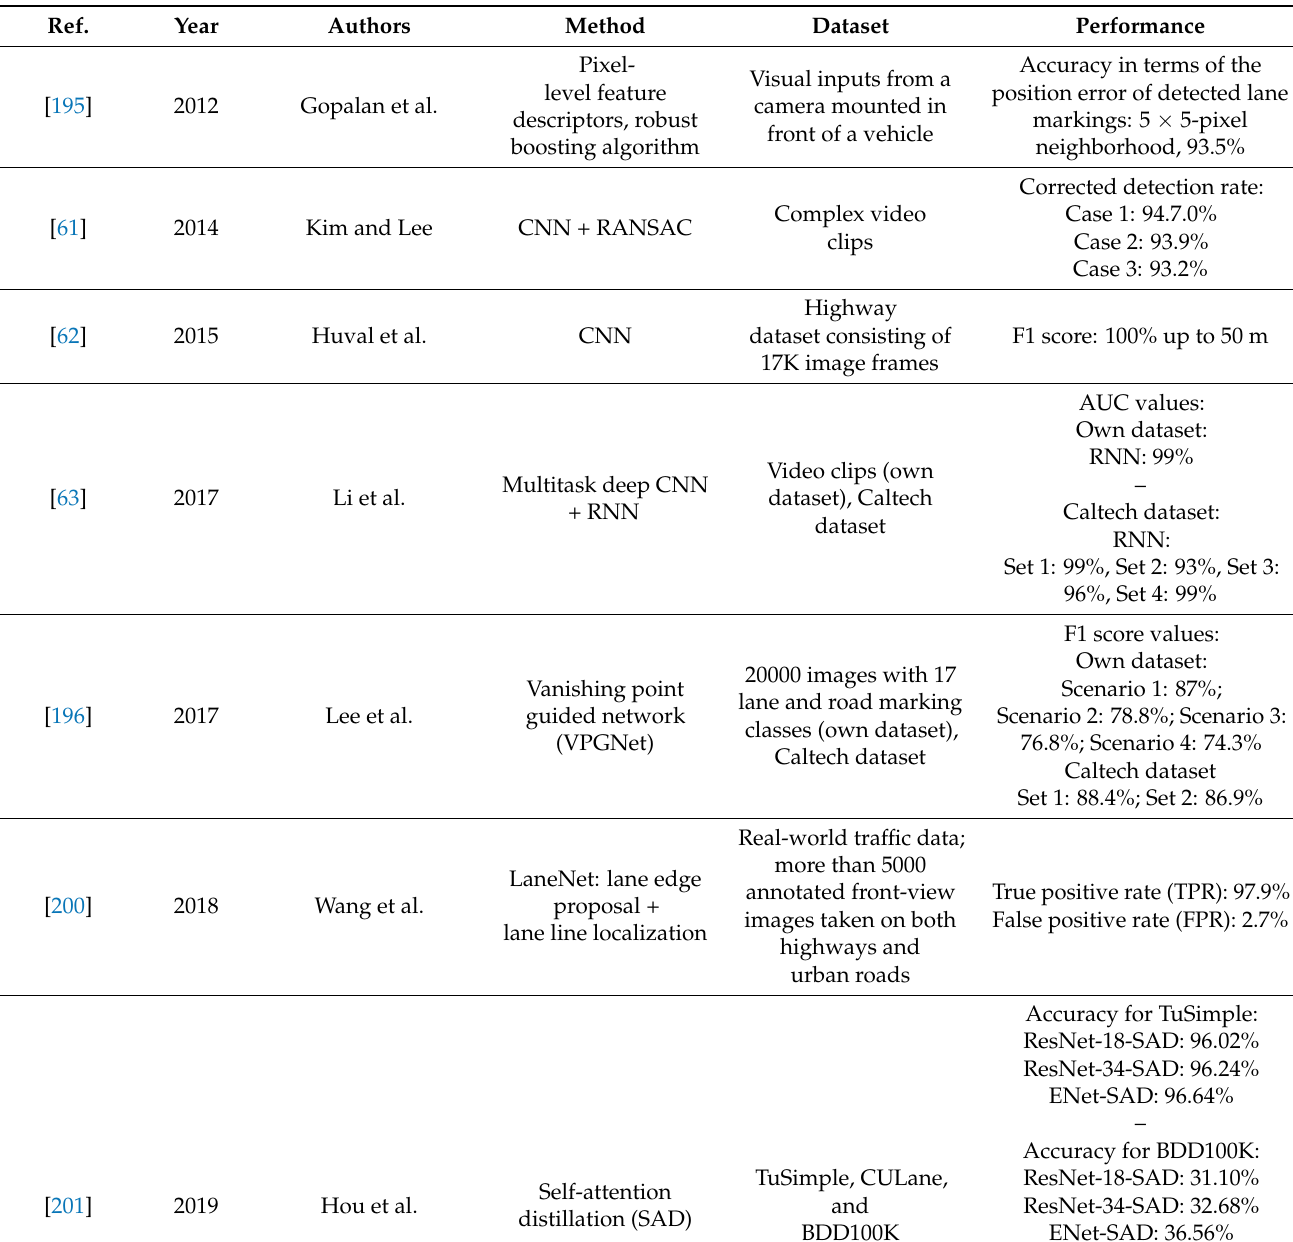
Table 7. Lane Line Detection Studies with CV